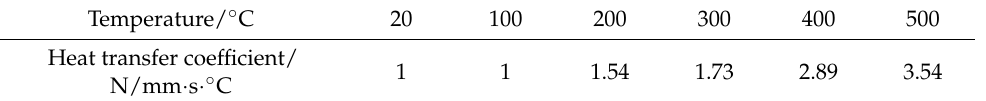
Table 6. Heat transfer coefficient values obtained during the fifth simulation.